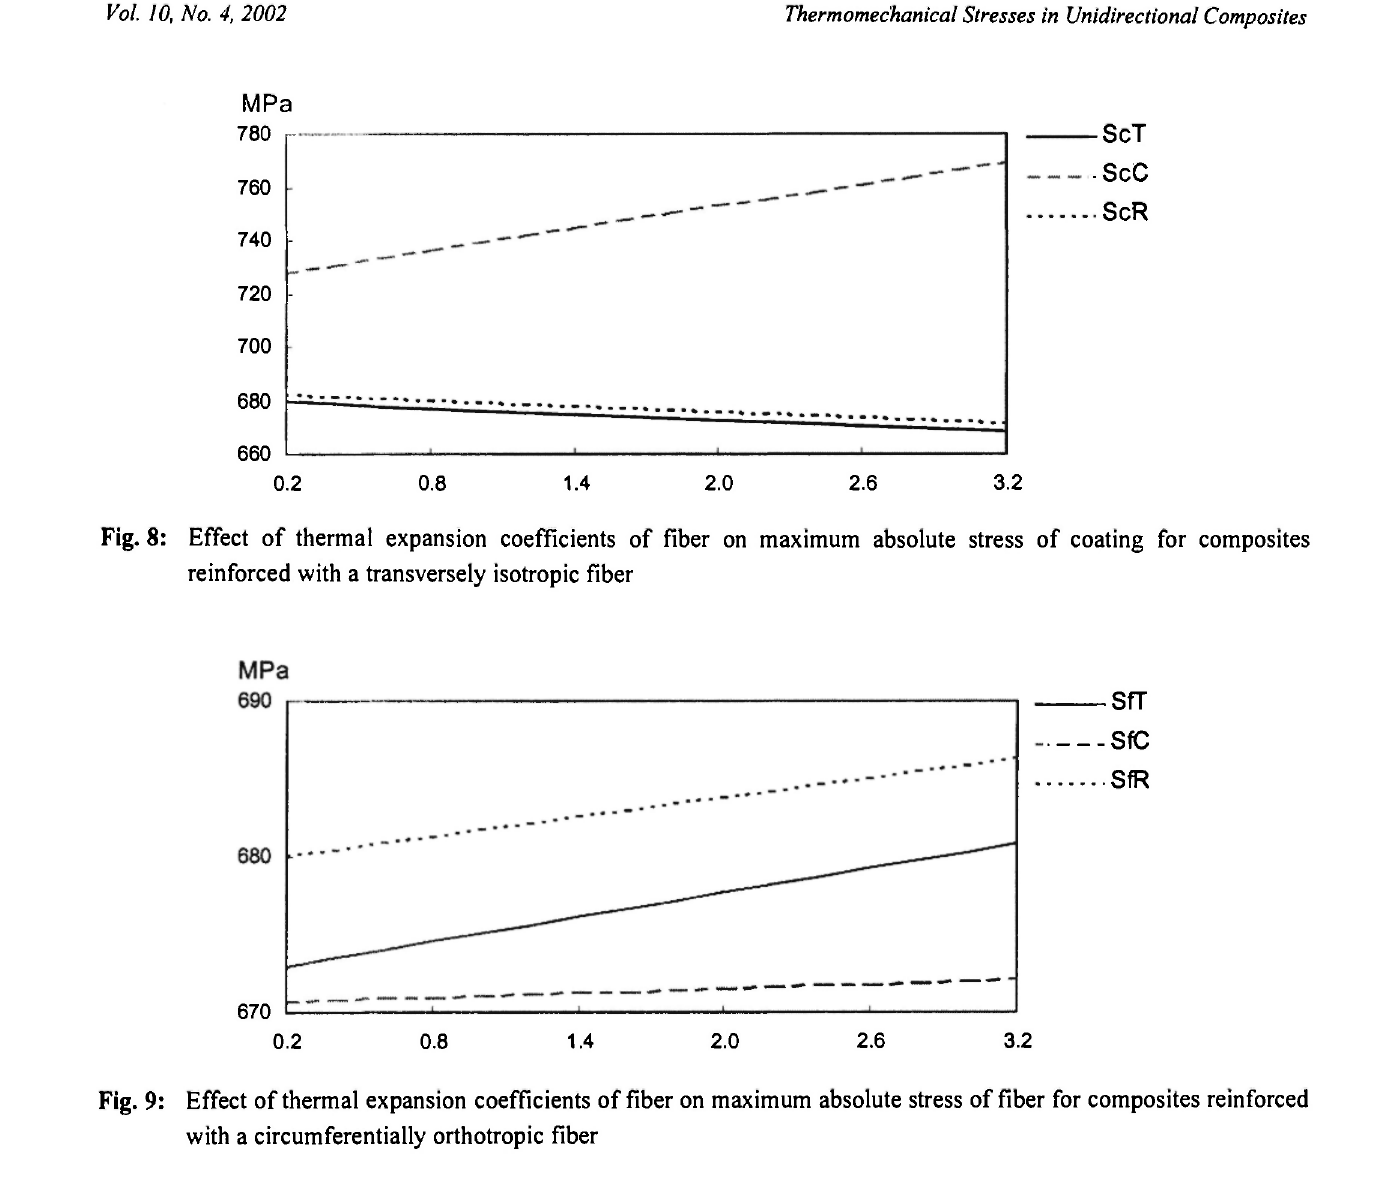
Fig. 9: Effect of thermal expansion coefficients of fiber on maximum absolute stress of fiber for composites reinforced with a circumferentially orthotropic fiber